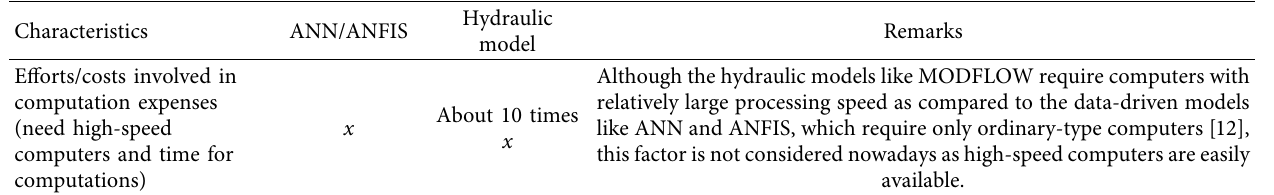
Figure 1: Groundwater depletion and pumping rates for Saq Aquifer (Qassim Region). Table 1: Review of data-driven models and hydraulic model